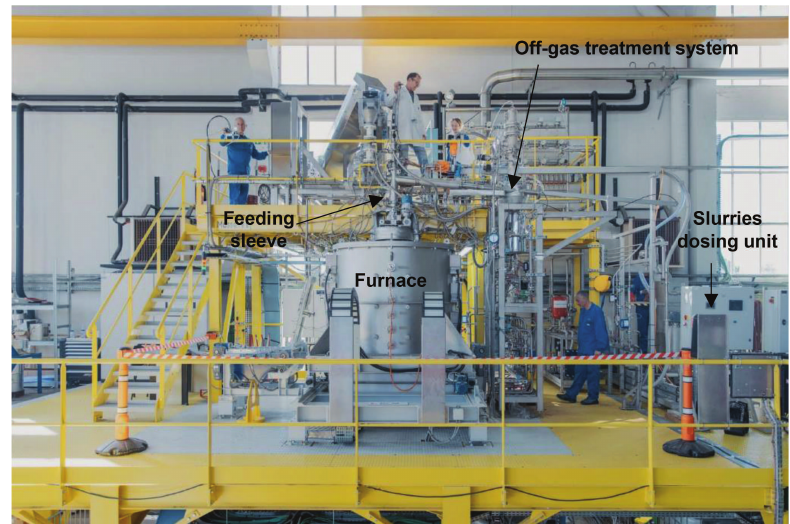
Fig. 7. Photo of the DEM&MELT inactive pilotdemonstrator at CEA Marcoule ( c (cid:13) Y.